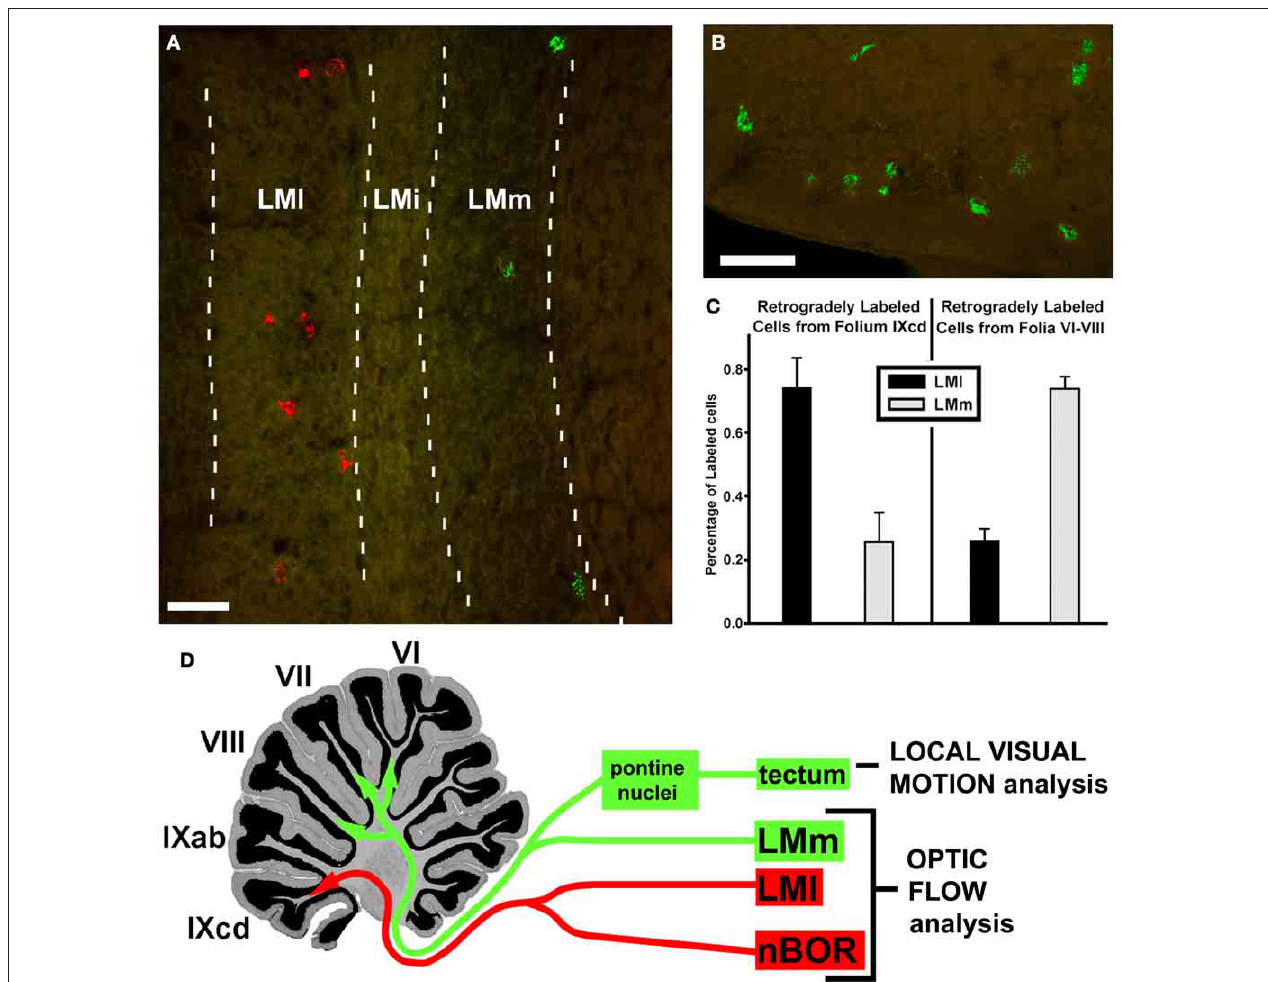
cells labeled in LMm (gray bars) and LMl (black bars) from injections in IXcd (left) and folia VI–VIII (right), collapsed from several cases. (D) Shows how in VI–VIII there is an integration of optic flow information, from LMm, with local motion information from a tecto-pontine system. From Pakan and Wylie (2006). LMi: intercalated subnucleus of LM. Scale bars: (A,B) = 100 µ